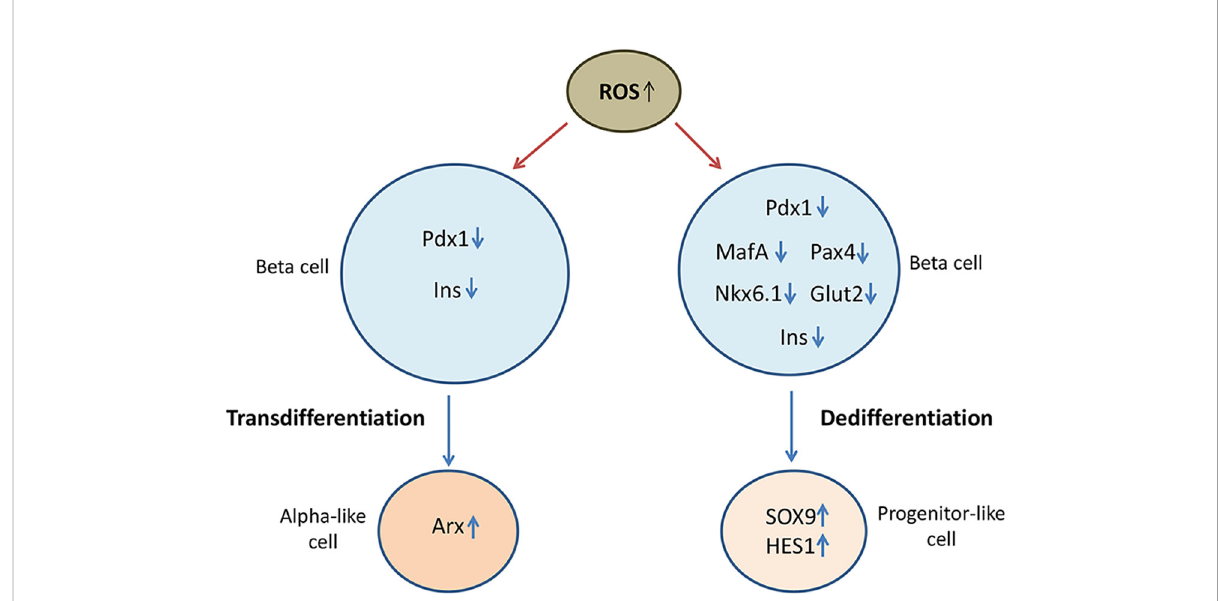
FIGURE 2 Oxidative stress compromises beta cell identity by altering expression of beta cell maturity genes and beta cell disallowed genes. Loss of beta cell identity through de-/trans-differentiation processes contributes to beta cell failure in diabetic condition. Oxidative stress-reduced expression of beta cell-fate markers such as duodenal homeobox factor-1 (Pdx-1), musculoaponeurotic fi brosarcoma oncogene homolog A (MafA), paired box 4 (Pax4) and homeobox protein Nkx6.1, decreases the expression of insulin (Ins) and glucose transporter GLUT1 and promotes the expression of progenitor markers such as SRY-box transcription factor 9 (SOX9) and hairy and enhancer of split-1 (HES1), suggesting occurrence of dedifferentiation process. By reducing expression of Pdx-1, oxidative stress may also lead to overexpression of alpha cell speci fi c aristaless-related homeobox gene factor (Arx) and consequently to transdifferentiation of beta cells into alpha